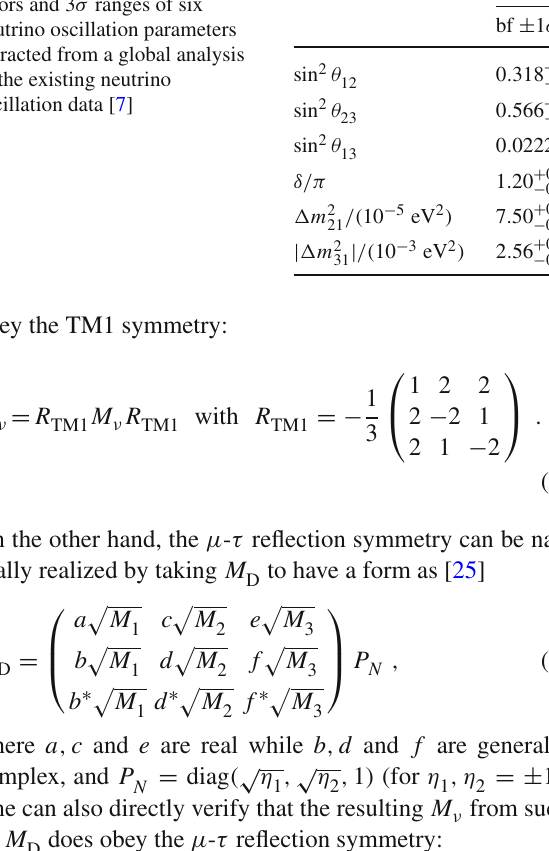
Table 1 The best-fit values, 1 σ errors and 3 σ ranges of six neutrino oscillation parameters extracted from a global analysis of the existing neutrino oscillation data